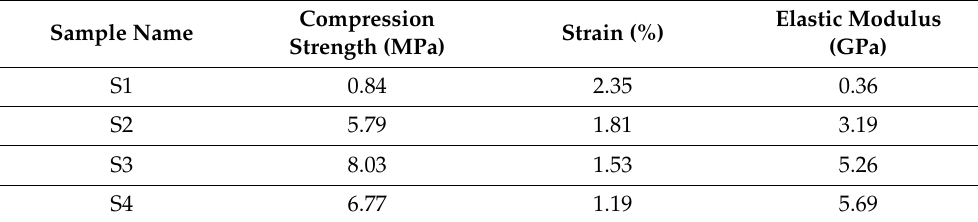
Figure 4. Comparison of mechanical properties in: ( a ) tensile strength, ( b ) tensile strain, ( c ) elastic modulus, ( d ) compression strength, ( e ) compression strain, ( f ) elastic modulus, ( g ) bending strength, ( h ) bending strain, and ( i ) elastic modulus. Table 4. Tensile properties of JCJC spent tea leaf composites. Table 5. Compression properties of JCJC spent tea leaf